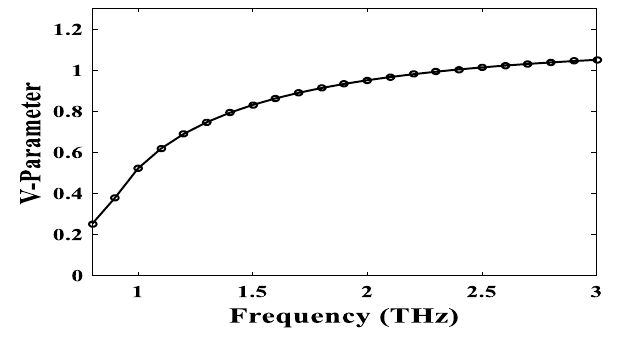
Fig. 10 Features of V-parameter versus frequency at THz for opti- mum